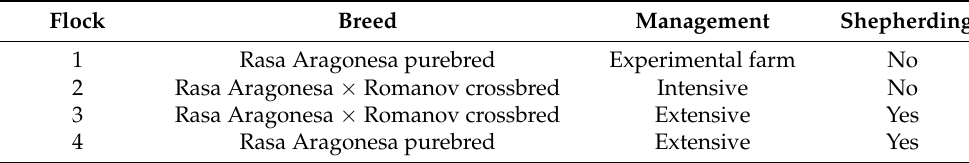
Table 1. Characteristics of the lambs and flocks used in the experiment. Flock Breed Management Shepherding 1 Rasa Aragonesa purebred Experimental farm No Rasa Aragonesa × Romanov crossbred Intensive No 3 Rasa Aragonesa × Romanov crossbred Extensive Yes 4 Rasa Aragonesa purebred Extensive Yes